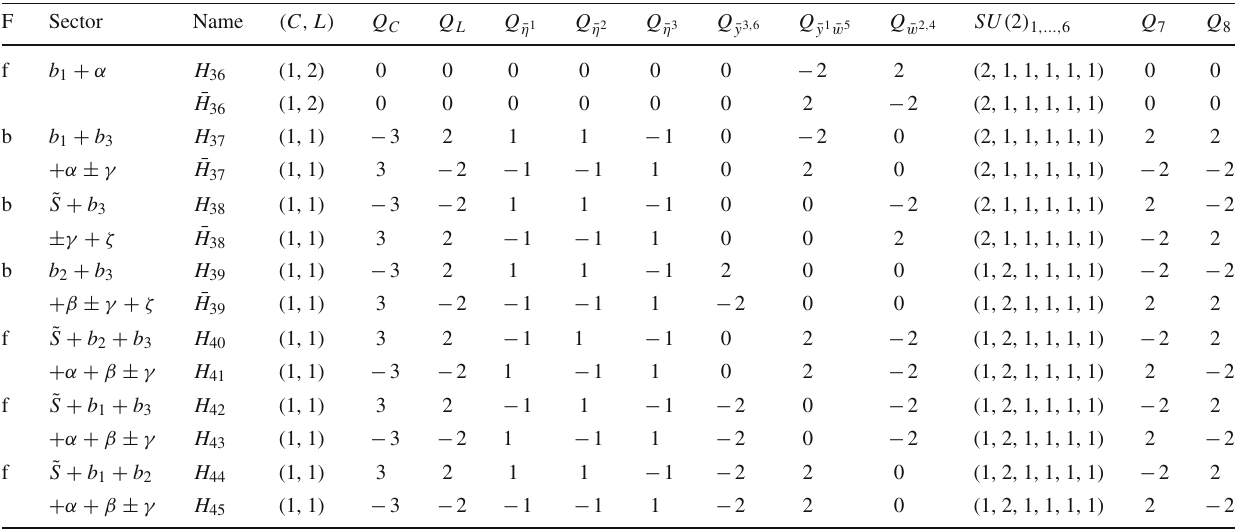
Table 9 Exotic spinorials without ˜ S -partners (i). All charges are multipled by 4 and the combination ζ = 1 + b 1 + b 2 + b 3 has been